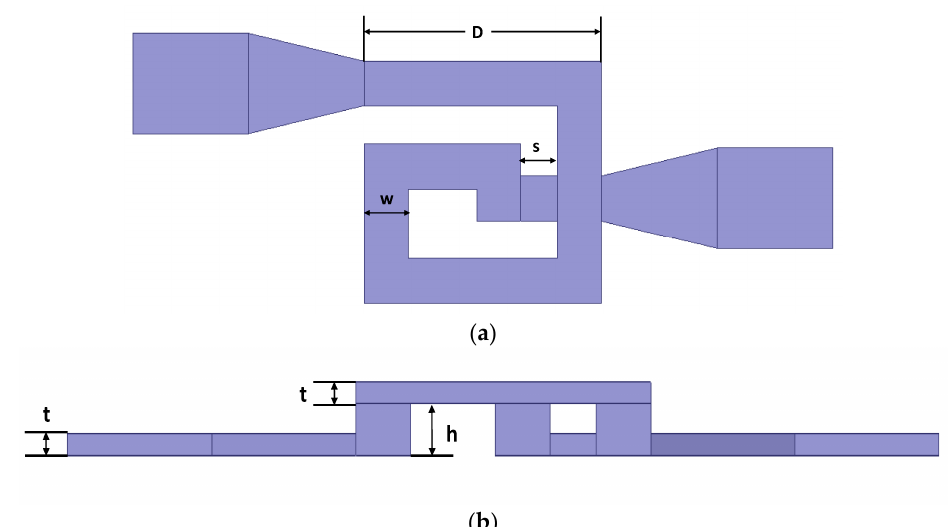
Figure 2. Geometric parameters of the MEMS suspended inductor coil. ( a ) The top view of the inductor coil; ( b ) the side view of the inductor coil.